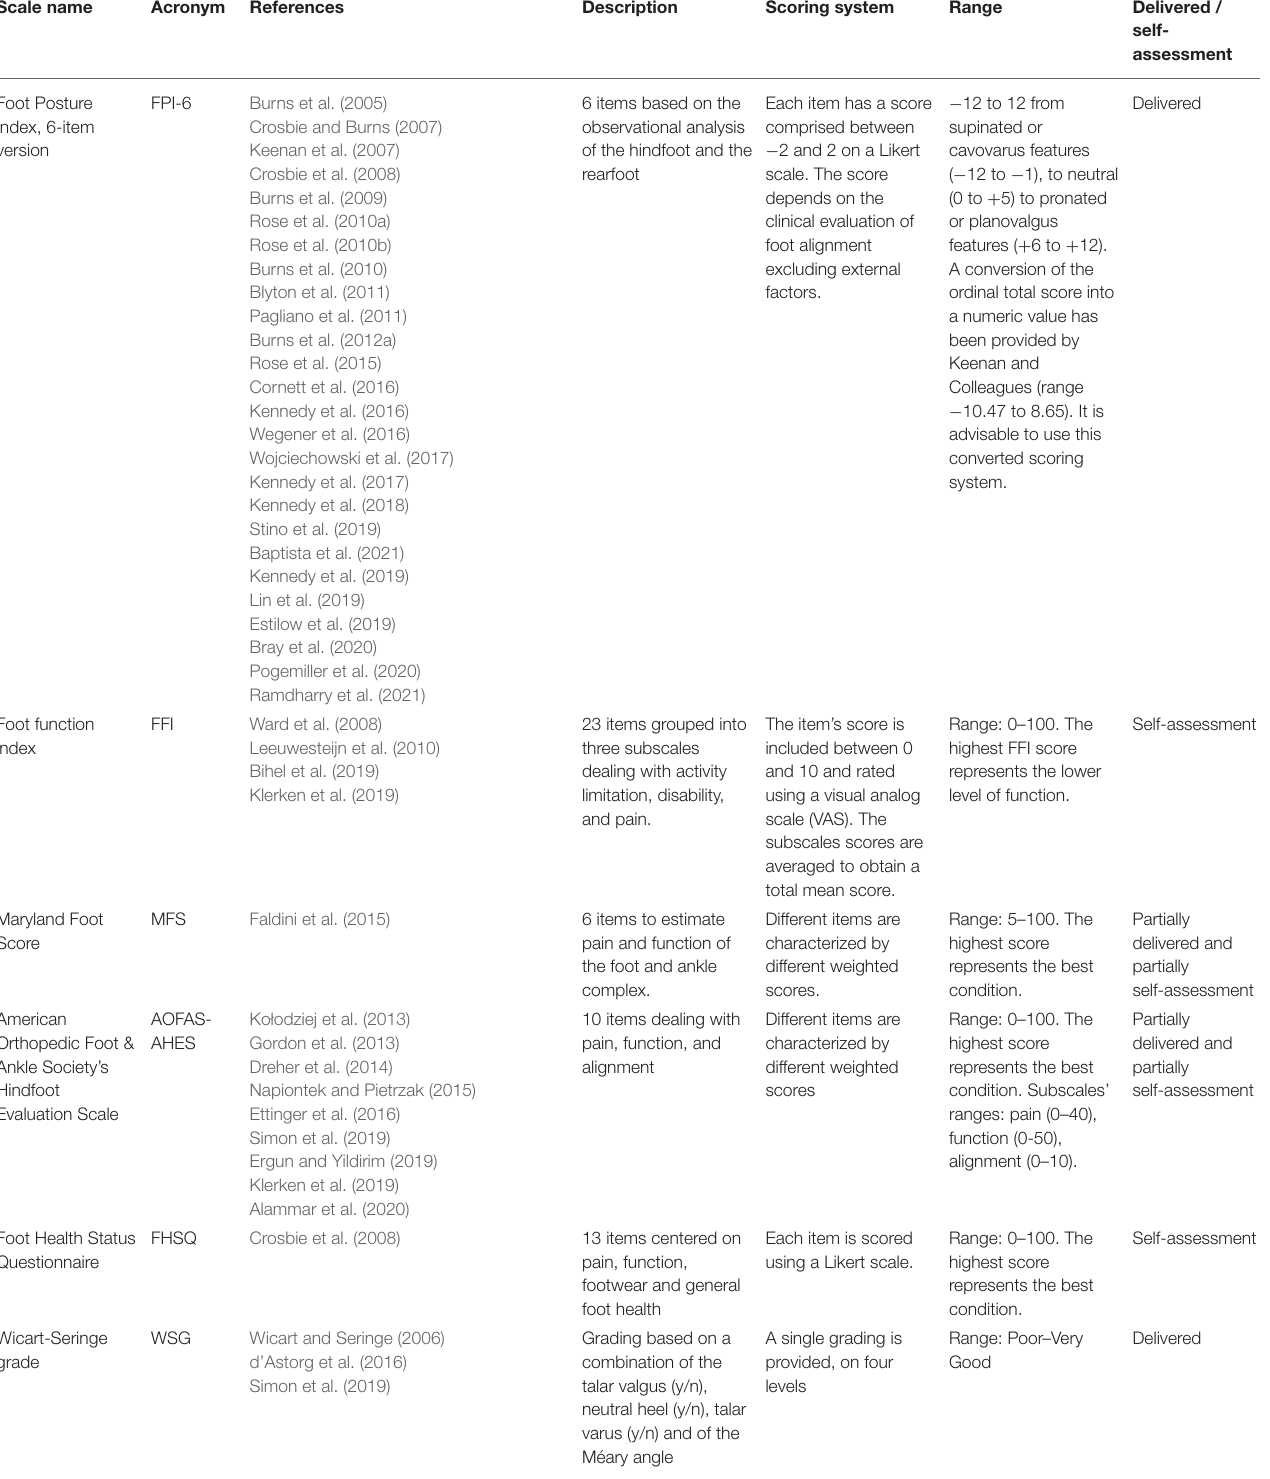
TABLE 1 | Scales used in literature for foot assessment in CMT patients, related articles, and main